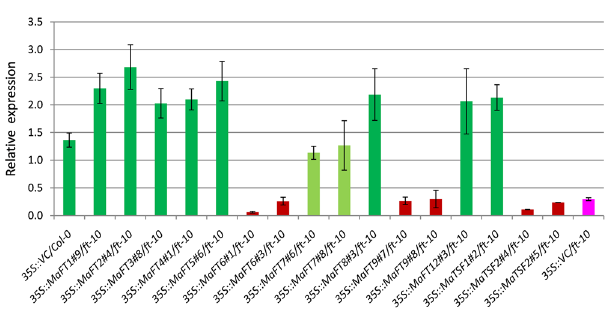
Figure 10. Detection of Arabidopsis AP1 expression by qRT-PCR in transgenic Arabidopsis lines ectopically expressing banana MaFT / TSF genes. The SAND (At2g28390) gene of Arabidopsis was used as reference